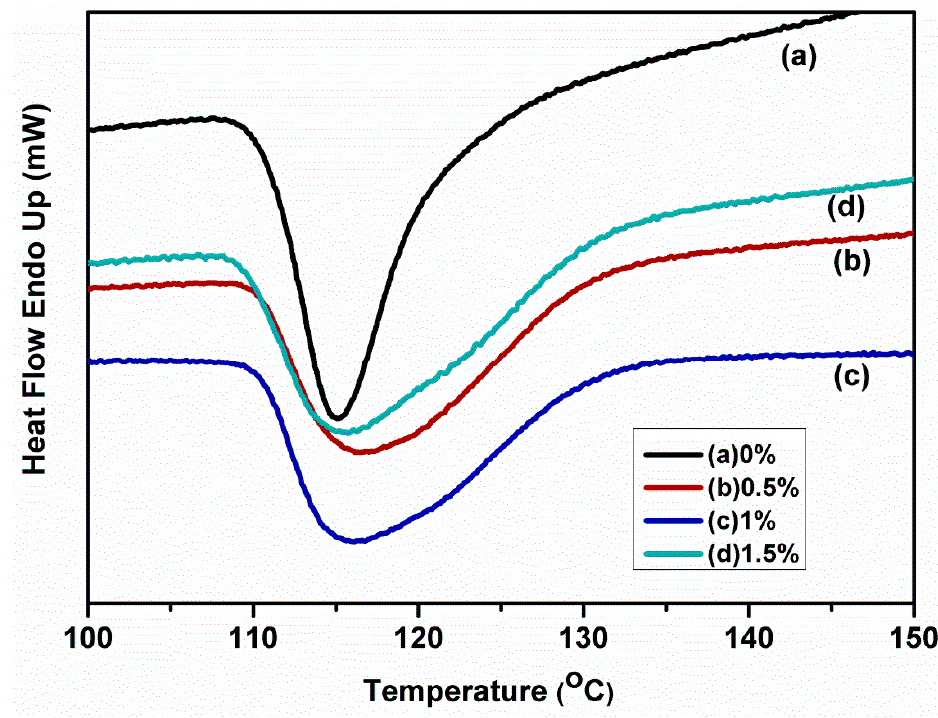
Figure 6. The DSC diagram of PLLA-PEG200 with different amounts of o-MMT nanocomposite material. The crystallization curves were under non-isothermal crystallization. The amount of o-MMT was ( a ) 0 wt%, ( b ) 0.5 wt%, ( c ) 1.0 wt%, and ( d ) 1.5 wt%, respectively. Table 1. The t 1/2 , ∆ H c , and crystallization time list of the PLLA-PEG copolymer and the nanocom- posites, adding different amounts of